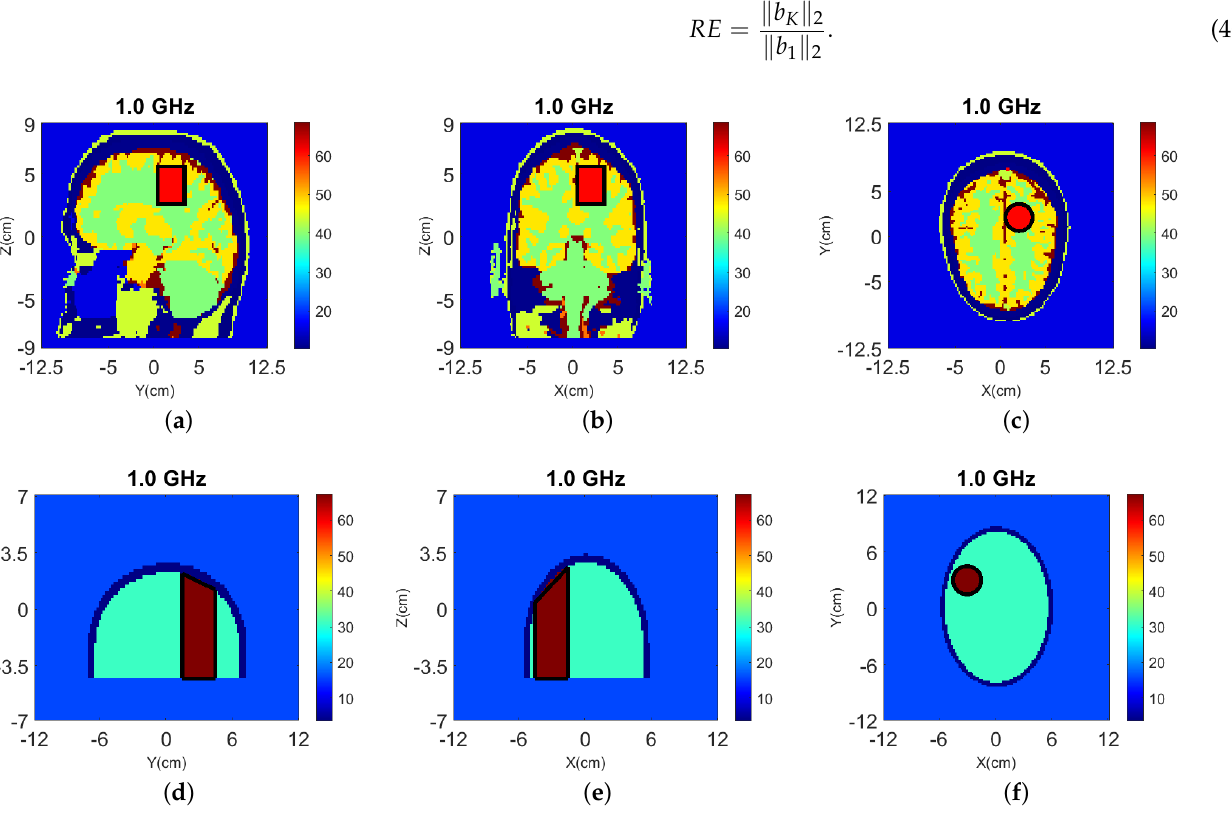
Figure 4. Dielectric constant distribution (cid:60) ( ε r ) for our validation models. Top : ( a ) y-z slice, ( b ) x-z slice, and ( c ) x-y slice for the numerical head model; Bottom : ( d ) y-z slice, ( e ) x-z slice, and ( f ) x-y slice for the experimental